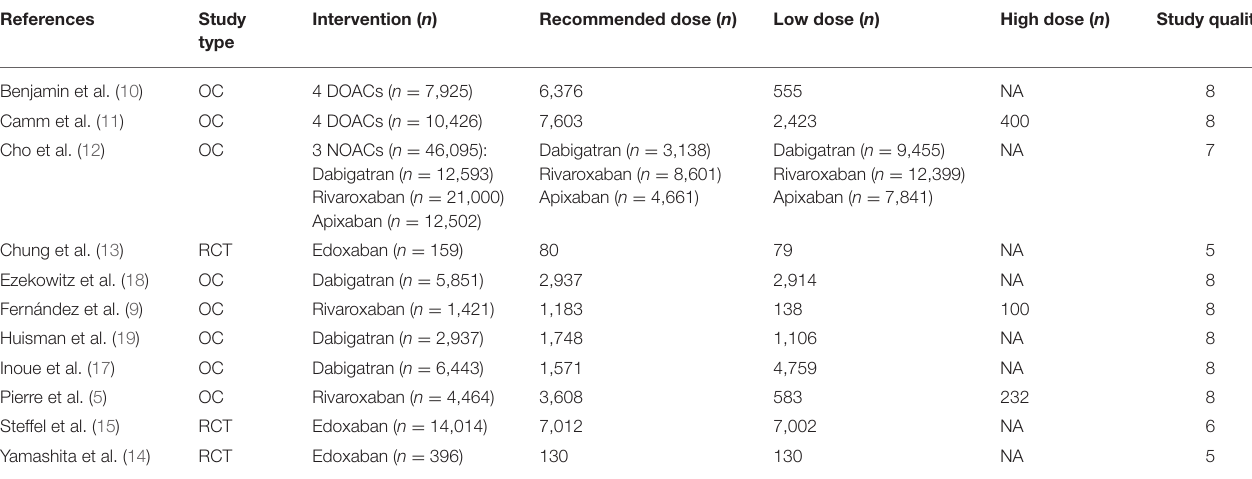
TABLE 2 | General features of the eligible studies.